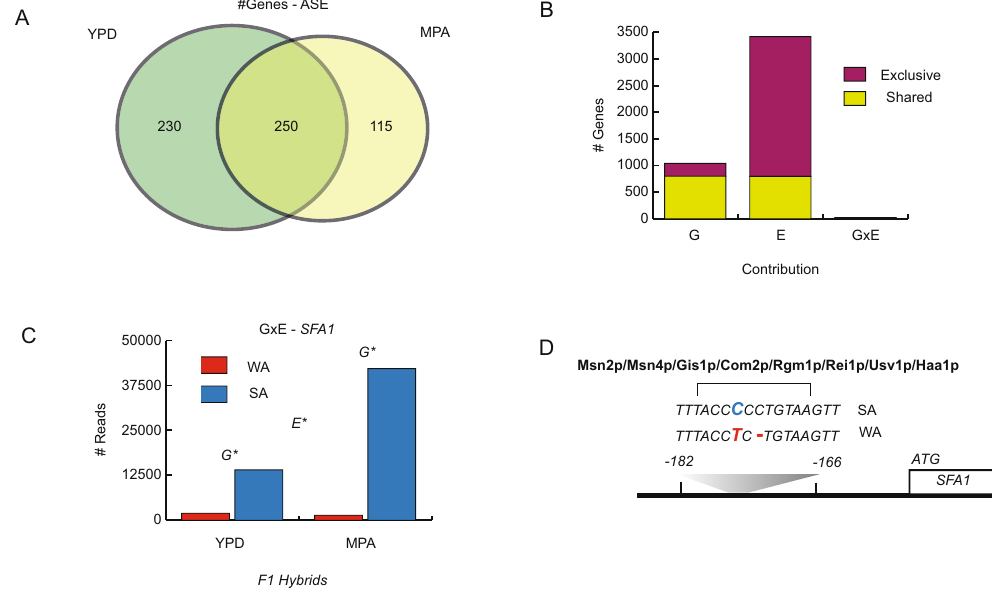
Figure 4. ASE and GxE interactions in F1 Hybrids. ( A ) Number of Genes exhibiting ASE in individuals subjected to YPD (green) and MPA (yellow) treatments. ( B ) Number of genes exhibiting significant Genotype (G), Environment (E) and GxE (Genotype × Environment) components derived from F1 hybrid expression data. The number of genes with shared (genes with more than one significant component, in yellow) and exclusive (exhibiting a sole significant component, in purple) components are depicted. ( C ) Number of WA and SA reads of F1 hybrids grown in YPD and MPA; SFA1 is given as an example of a gene affected by both genotype and environment (GxE), (G * ) and (E * ) denote significant genotype and/or environment effects FDR < 0.05. ( D ) The sequence divergence between the SA and WA strains is between − 182 and − 166 bp from the SFA1 ORF. Also, the predicted binding differences due to the two polymorphisms are